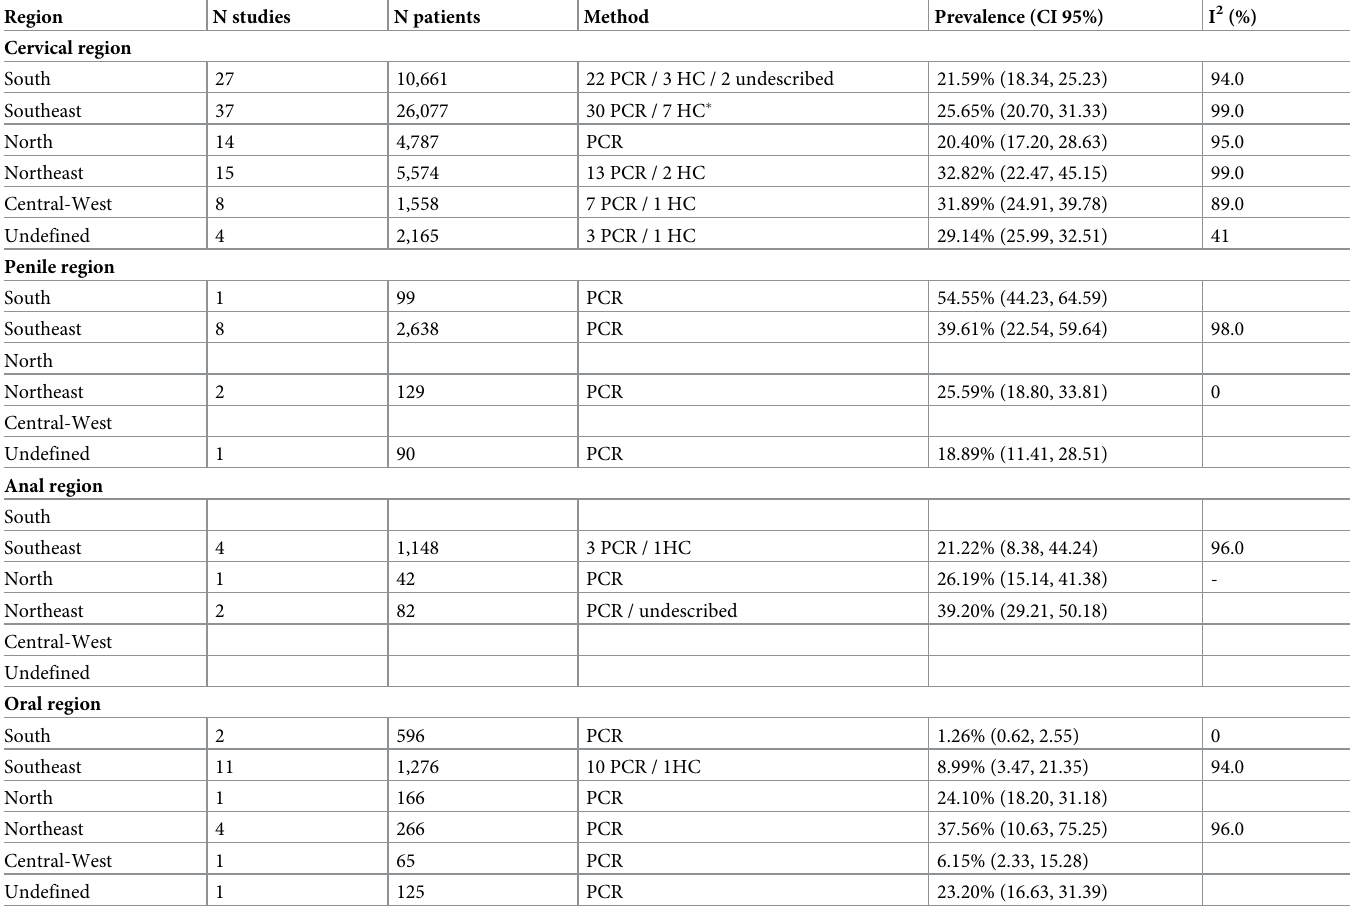
Table 1. Meta-analysis of the prevalence of HPV by geographic region in